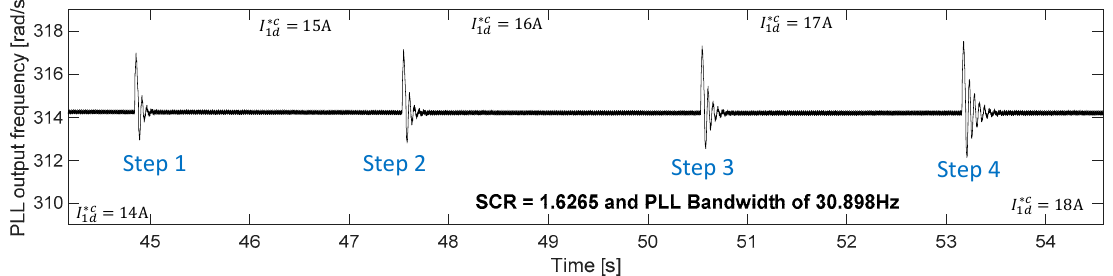
Figure 16. Transient response of frequency at the PLL output for a SCR of 1.6265 and for a PLL BW of 30.898 Hz, in the 4 steps considered in for the validation—Matlab data logging of the experimental waveforms.